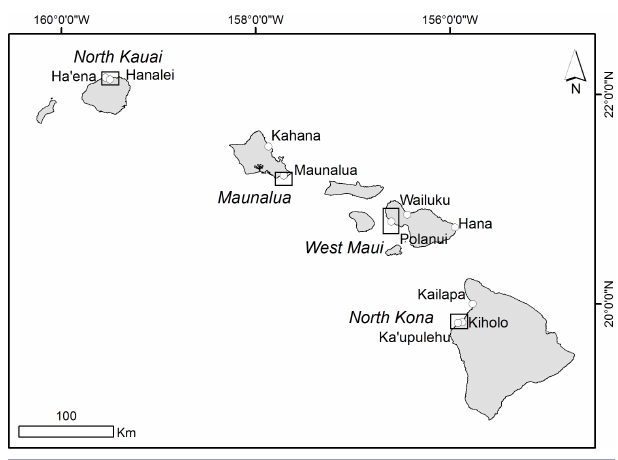
Fig. 1 . Participating community locations for the development of the monitoring methods in the main Hawaiian Islands. Boxed regions indicate areas where the majority of the monitoring data was